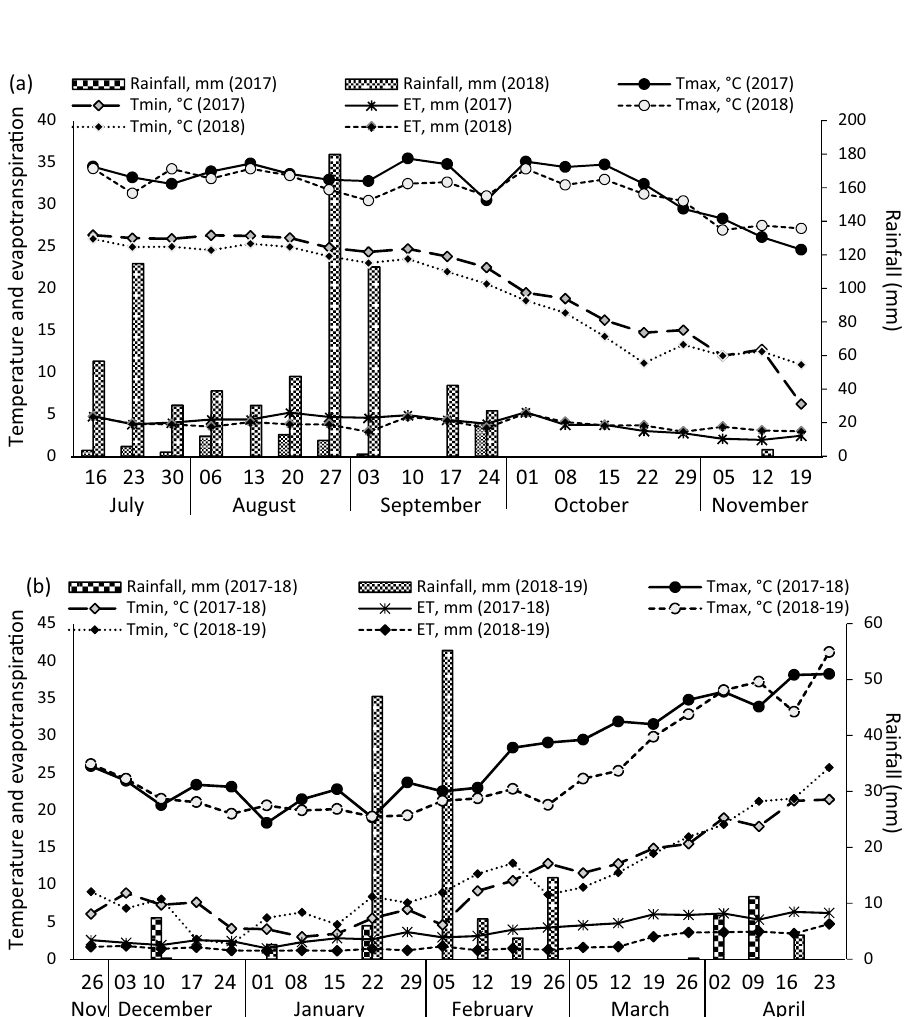
Figure 8. Weekly average temperature, evaporation (ET) and rainfall during ( a ) soybean and ( b ) wheat during 2017–2018 and 2018–2019 crop growing